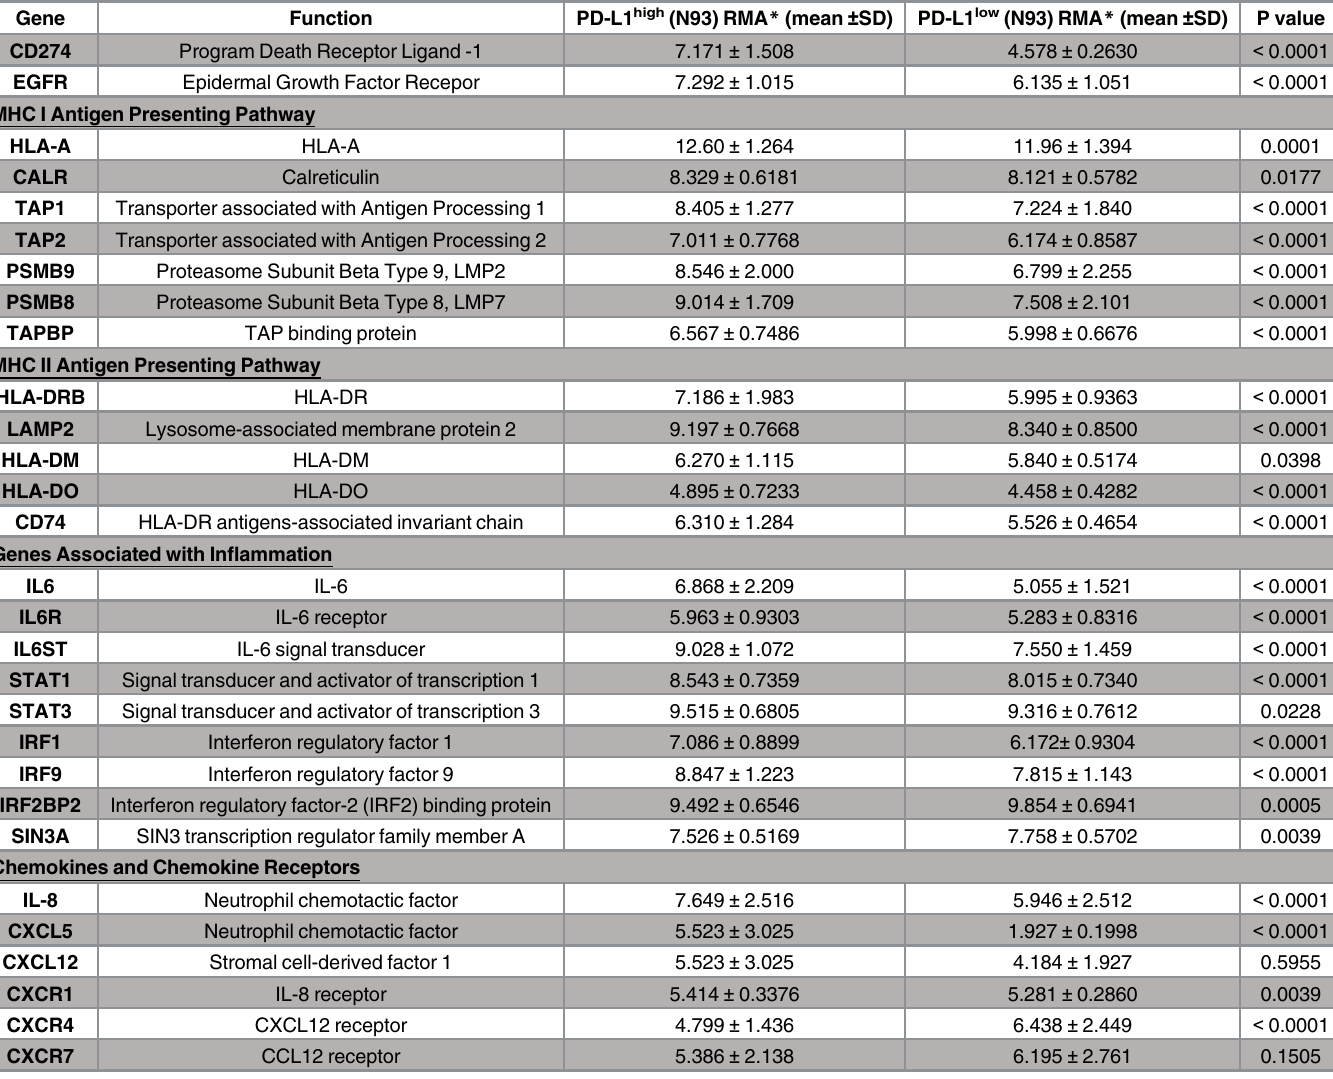
Table 2. The expression of immune-related genes associated with PD-L1 High vs PD-L1 Low expressing lung cancer cell lines from CCLE.